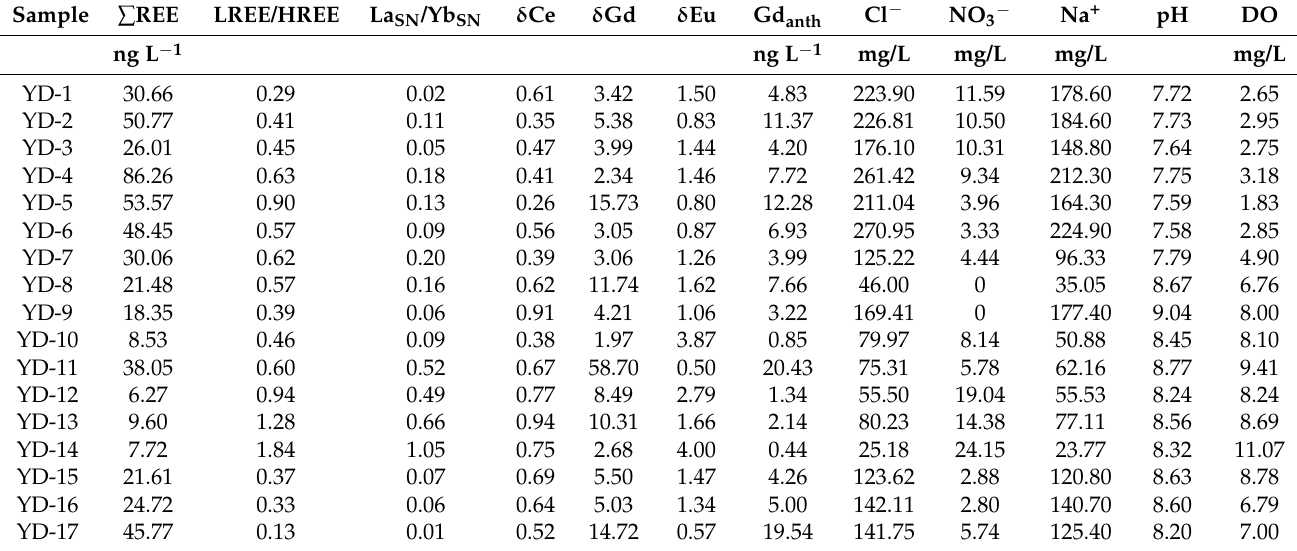
Table 2. Element anomalies of water samples from the Yongding